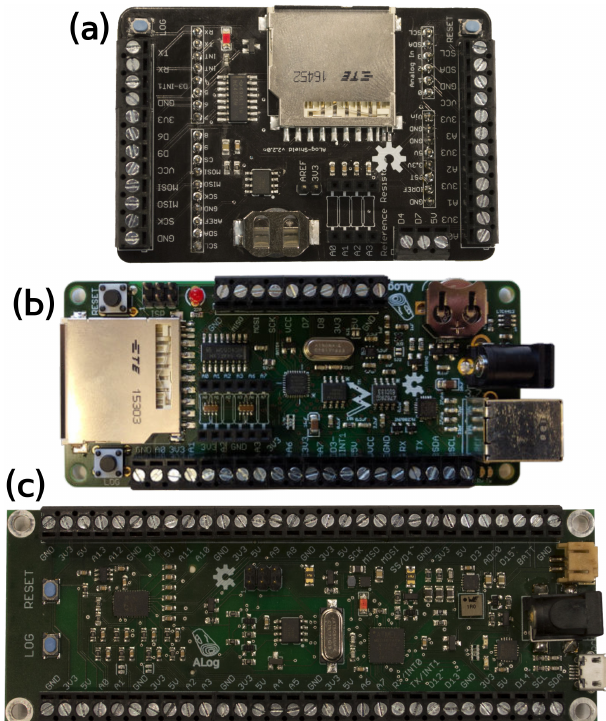
Figure 1. Photos of the ALog series of data loggers. (a) The ALog Shield 2.2 (Wickert et al., 2018b), which nests atop a standard Ar- duino board. (b) The ALog BottleLogger 2.2 (Wickert and Sandell, 2017). (c) The ALog BottleLogger 3.0 (Sandell et al., 2018); the battery and SD card holders are on the reverse